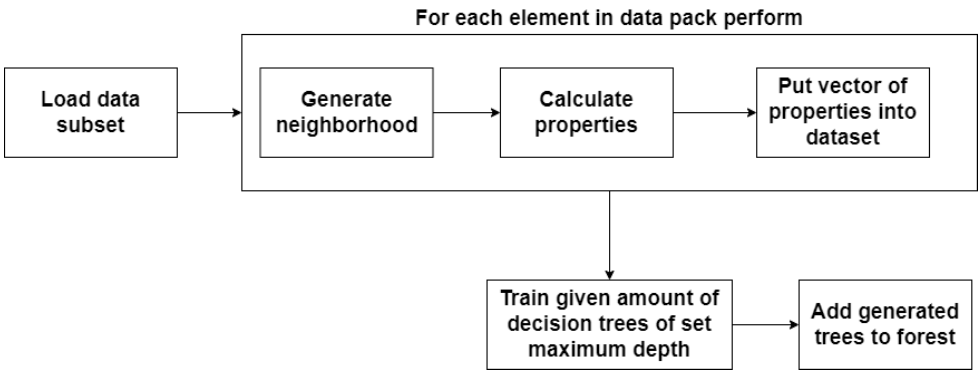
Figure 15. Training with single data package.